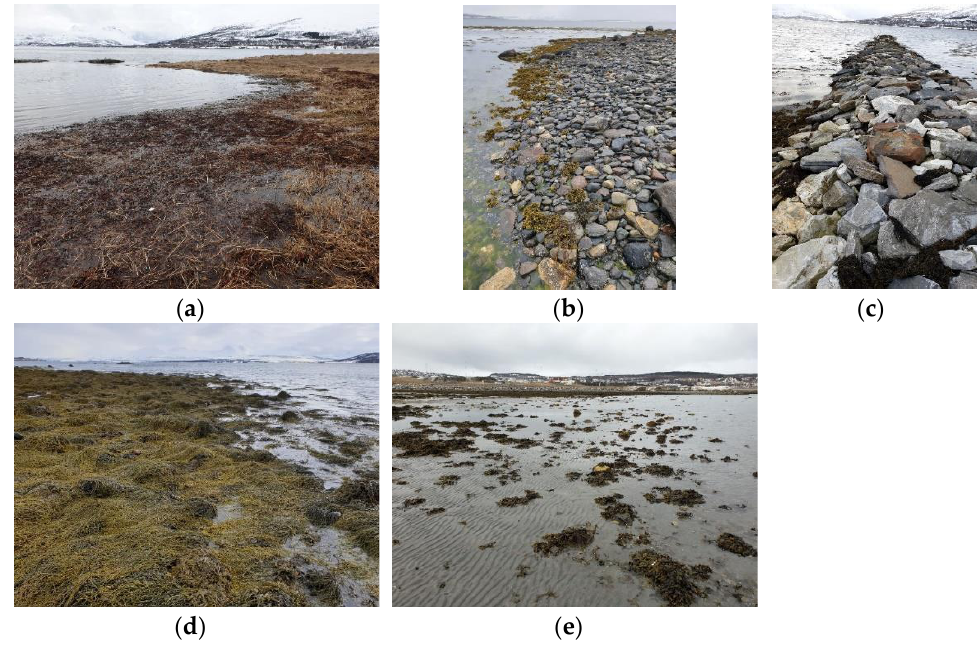
Figure 9. Photos taken at Langnes showing the variability of intertidal zone type and challenges in accessing and precisely defining the water line: ( a ) coastal meadow, ( b ) stone beach, ( c ) stone dam, ( d ) stone beach covered by kelp and floating kelp, and ( e ) mudflat with some kelp. Table 4. Times and predicted and hindcast modeled tidal levels of GPS tracks in Avløsbukta (Hillesøy) during fieldwork on 6–7 June 2020. Approximative tidal reference levels extracted from Kartverket [12]. Water Level (Pred.) Water Level (Obs.) Approx. Time (Ref. MSL) (Ref. MSL)